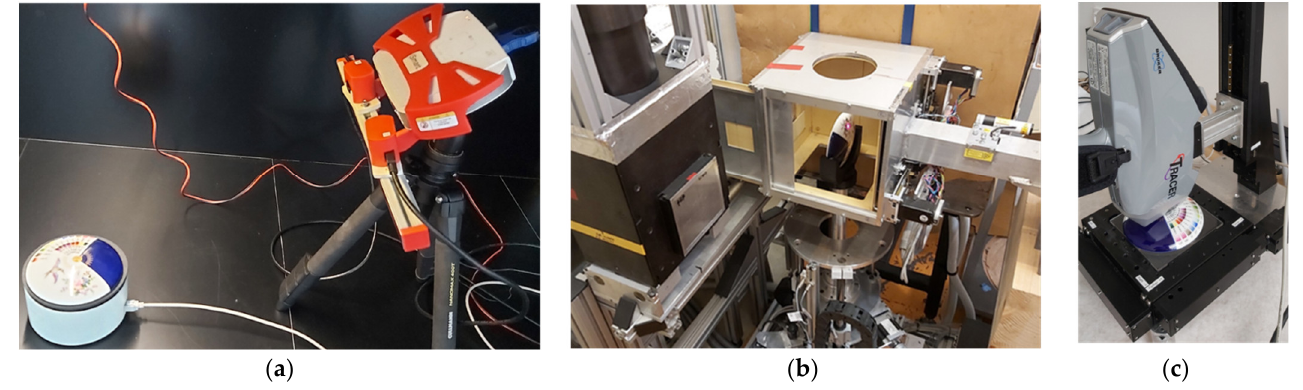
Figure 1. ( a ) The 3D structured-light scanning procedure, ( b ) the experimental setup of the PGAI measurement at the NIPS-NORMA facility of the BNC, and ( c ) position-sensitive xyz XRF scanning device.